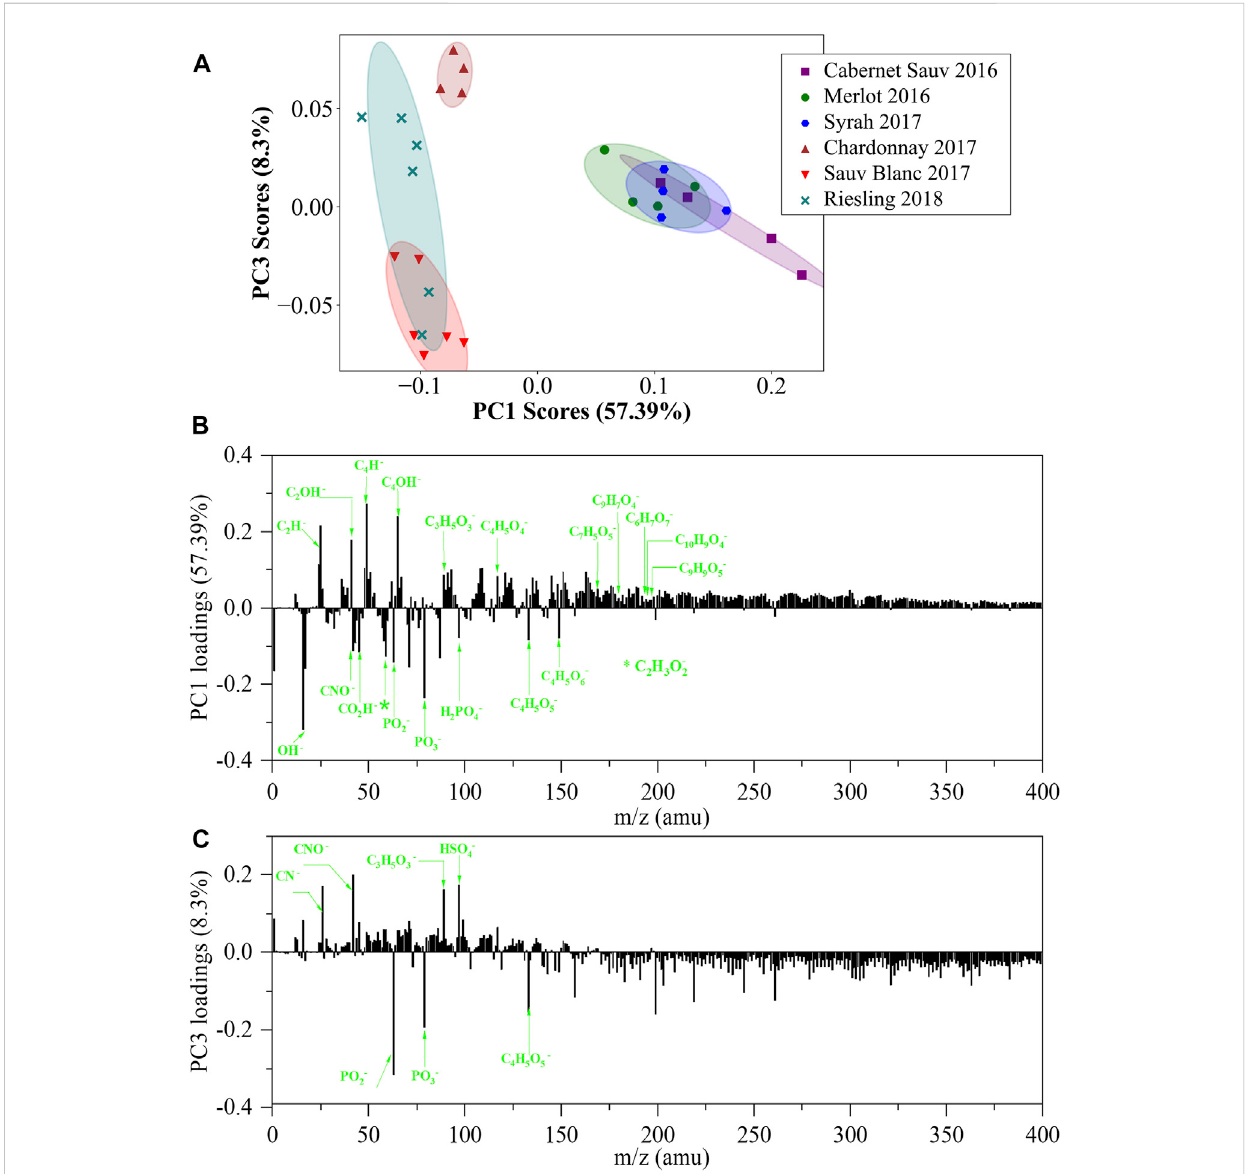
PCA analysis of in situ liquid SIMS spectra from the six representative wines from a single manufacturer in negative mode. (A) Scores plot of the fi rst principal component (PC1) versus the third principal component (PC3) from the spectra of in situ liquid SIMS. (B) Corresponding loadings plot of PC1indicatingtheseparationbetweentheredandwhitewines. (C) CorrespondingloadingsplotofPC3indicatingtheseparationamongthewhitewines. More assignment of the loadings of PC1 and PC3 can be seen in Supplementary Tables S2,